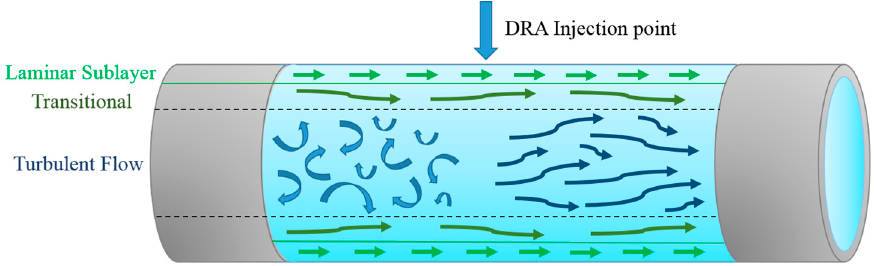
Figure 1. Schematic diagram for the methods of added polymer to a solution with pipeline turbulent flow.